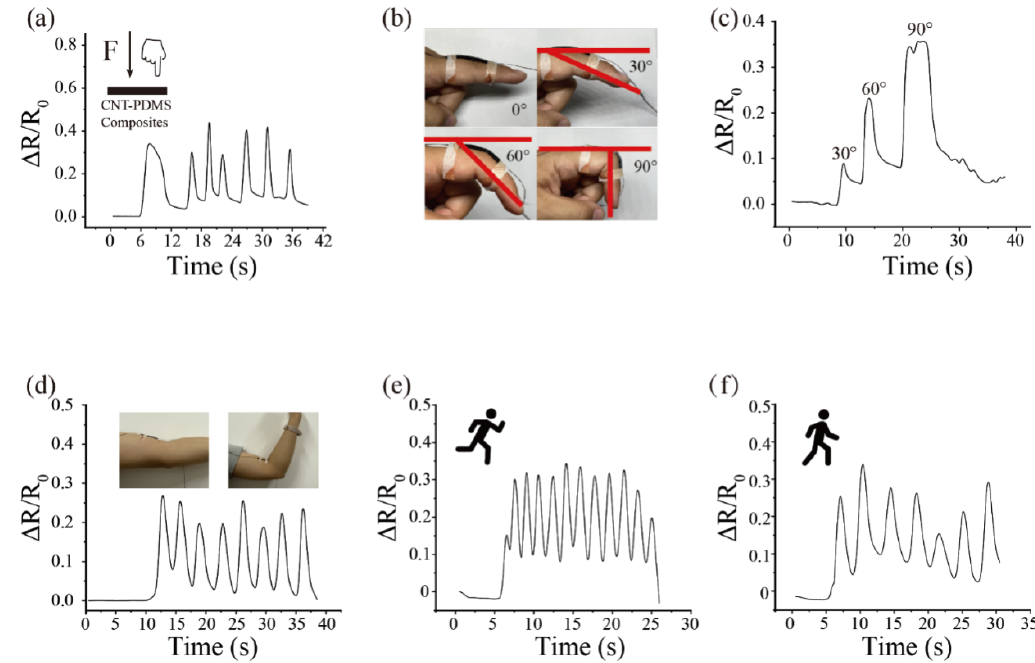
Figure 5. Application of the CNT-PDMS composites sensor ( a ) resistance changes by finger touch CNT-PDMS composites sensor, ( b – c ) resistance changes when the fingers are bent to different degrees, ( d ) CNT-PDMS composites sensor to monitor the joint and muscle movements. ( e – f ) resistance changes during running and walking.